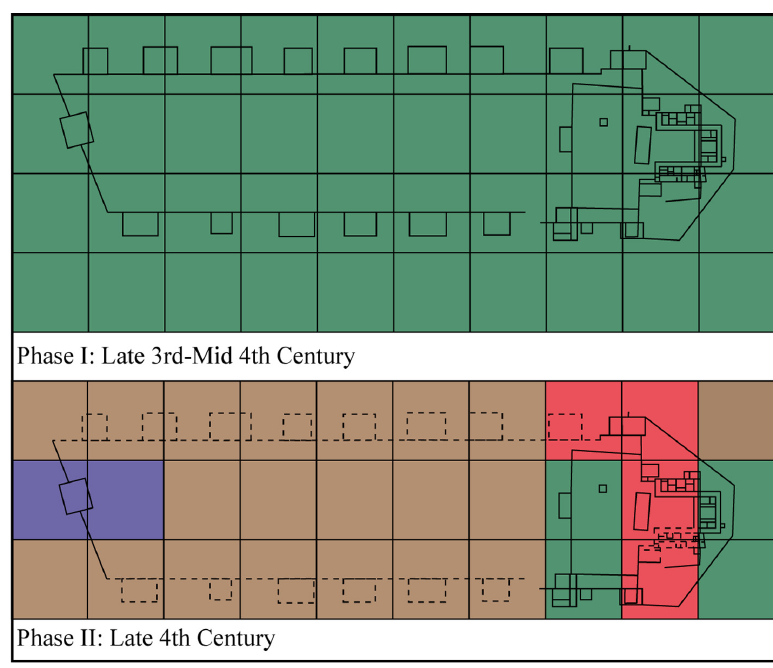
Figure 8: A low-resolution view of transformation at Borg, highlighting different types of transformational activity laid out in Table